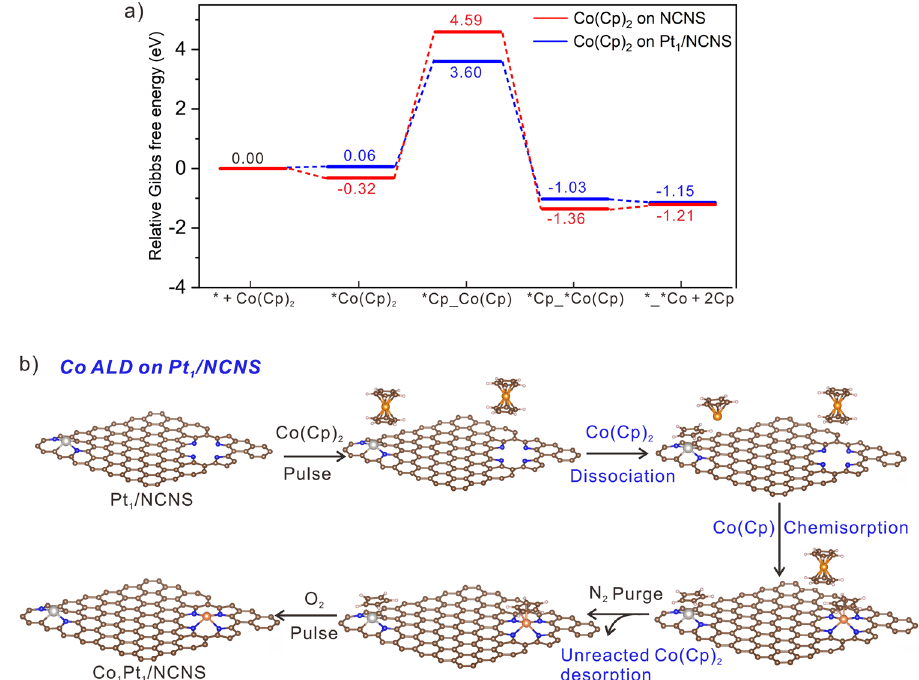
Fig. 5 Illustration of theoretical understanding of the Co ALD process. a Theoretical reaction coordinate for Co(Cp) 2 deposition on pristine NCNS and Pt 1 /NCNS. The Gibbs free energies were calculated at T = 523 K and P = 1 atm. b Illustration of Co ALD process on Pt 1 /NCNS. The white, brown, blue, orange, and silver spheres represent H, C, N, Co, and Pt,